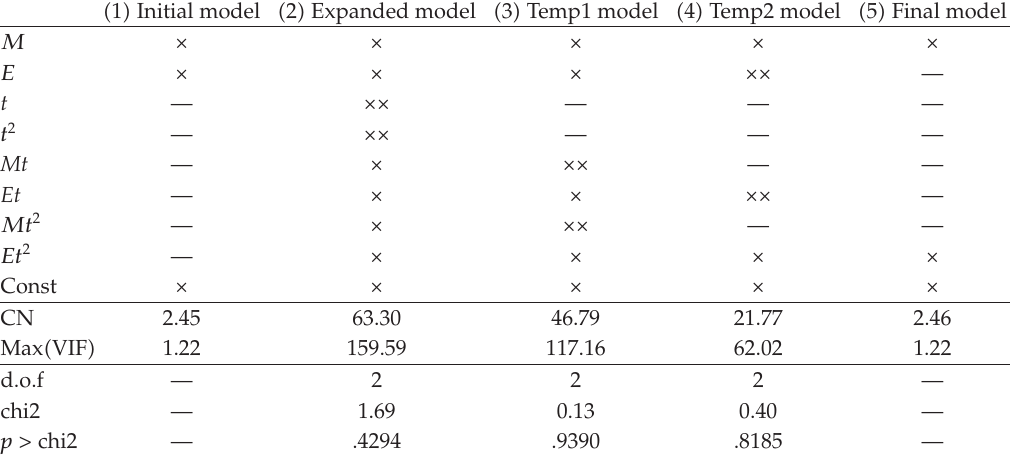
Table 4: Collinearity diagnostics and Wald tests. The columns in the table correspond to the Initial, Expanded, and Final models plus the two intermediate models referred to as Temp1 and Temp2. In the body of the table we can distinguish three segments separated by rows of blanks. In the first segment we find vertical sequences of the symbols “ × ” and “—” that indicate whether a given variable in the left stub is included in a given model. A second “x” in the columns corresponding to the Expanded, Temp1 and Temp2 models identifies the variables tested for significance as a block by Wald tests. The collinearity diagnostic CN, that stands for Condition Number, and Max (cid:2) VIF (cid:3) , that stands for Maximum Variance Inflation Factor are located in the second segment of Table 4 the results of the Wald tests are shown in the third